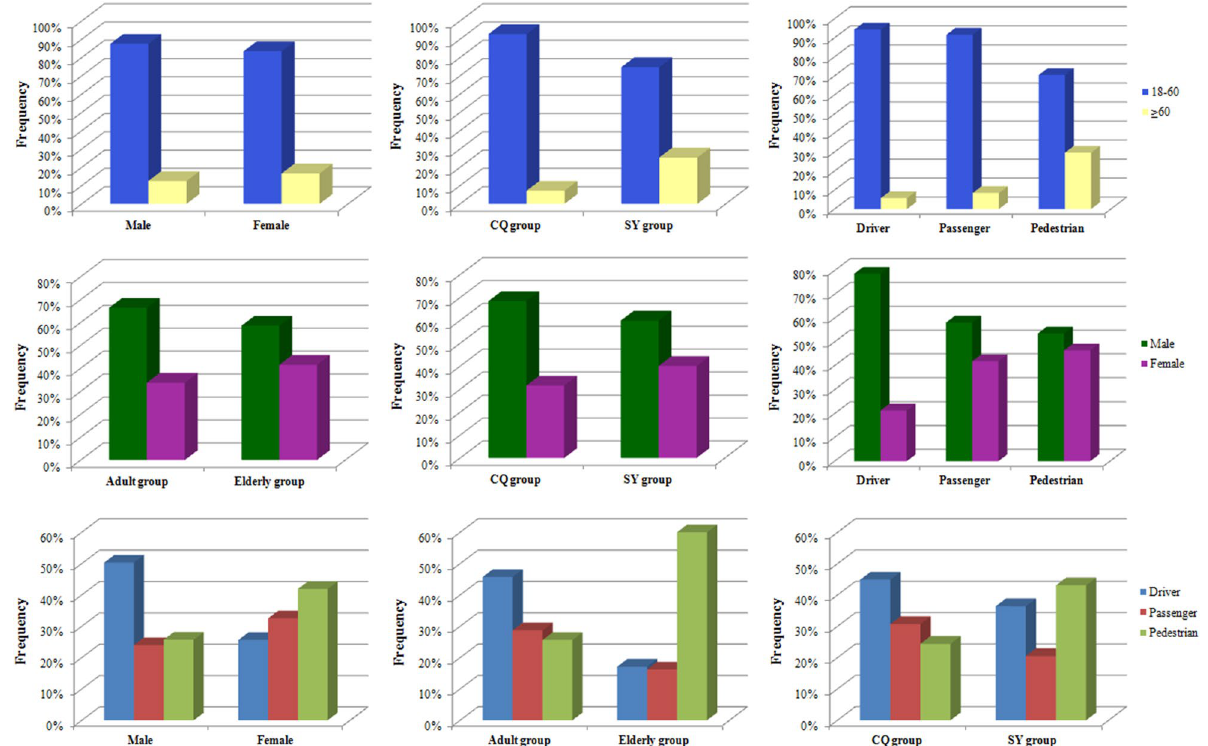
Figure 1. Distributions of age, sex and role according to different